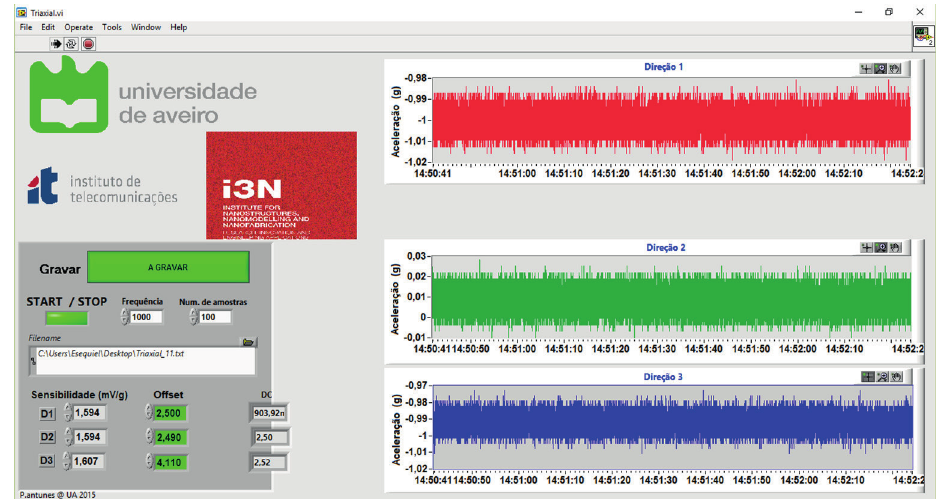
Fig. 8. Interface of the software used for data